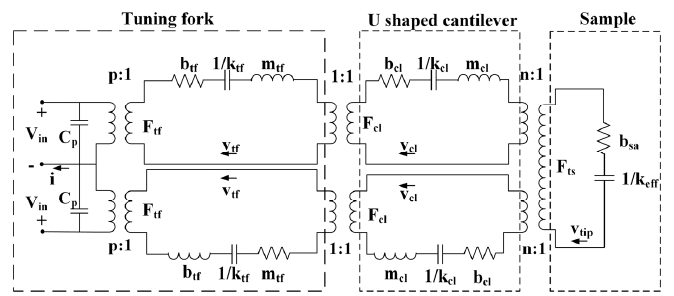
Figure 7. The electromechanical coupling model of an Akiyama probe.